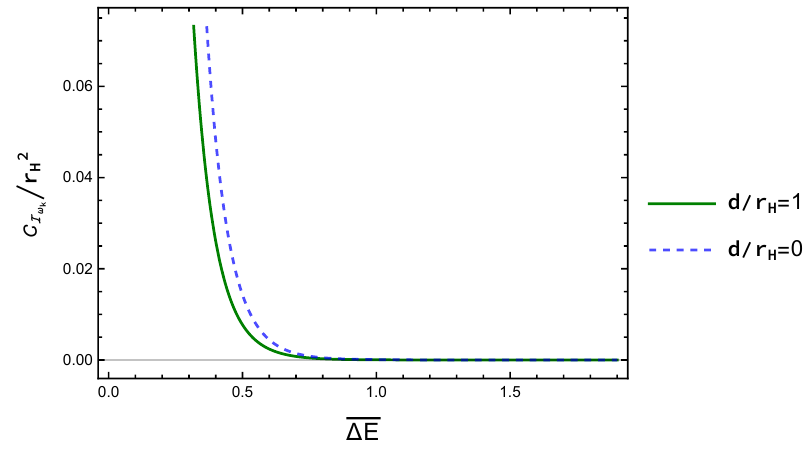
is plotted for two outgoing null detectors in a (1+1) dimensional Figure 5 . The quantity C I /r 2 H ωk Schwarzschild black hole spacetime with respect to the dimensionless transition energy ∆ E = r of the detectors, where ∆ E = ∆ E A = ∆ E B . The dimensionless field mode frequency is fixed at ω k = 1 and the dimensionless distance between the null paths are d/r H = 0 and d/r H = 1 .